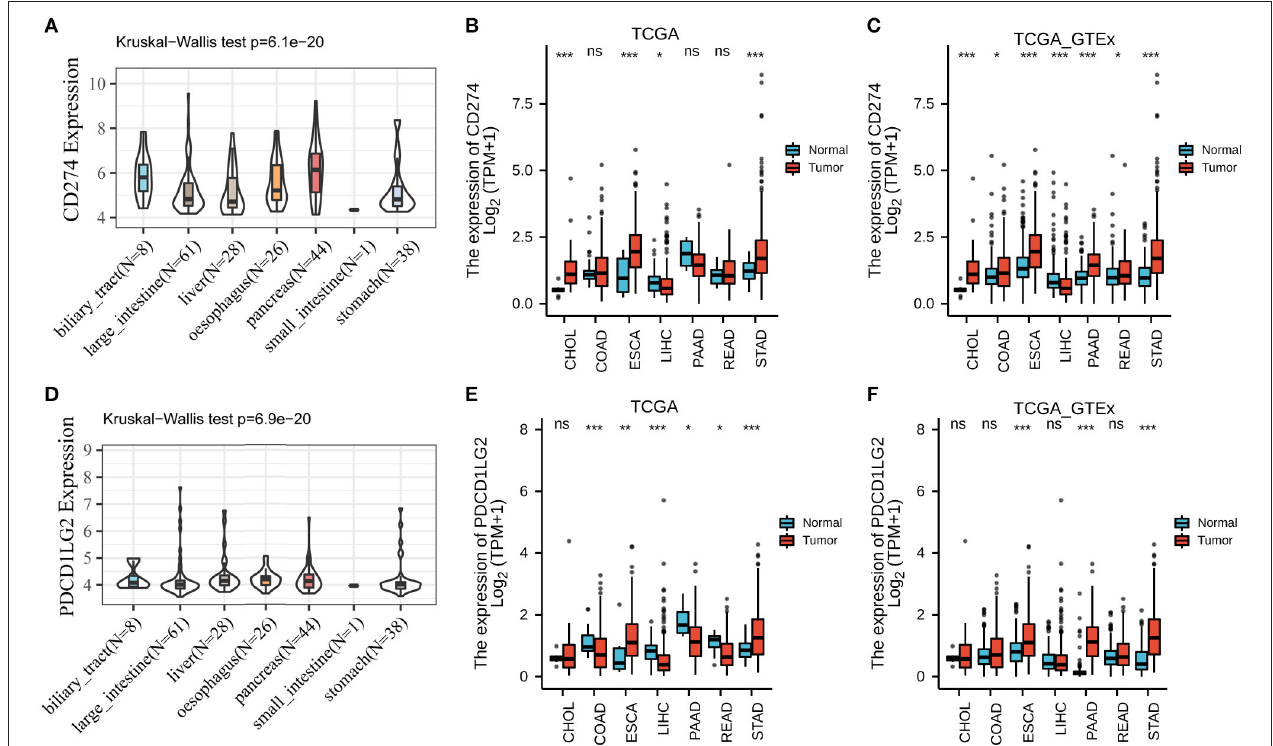
FIGURE 1 | CD274/PDCD1LG2 expression level in human pan-cancer. (A) The messenger RNA (mRNA) level of CD274 in Cancer Cell Line Encyclopedia (CCLE). (B) The mRNA level of CD274 in The Cancer Genome Atlas (TCGA). (C) CD274 mRNA level in TCGA and genotype-tissue expression (GTEx). (D) The mRNA level of PDCD1LG2 in CCLE. (E) The mRNA level of PDCD1LG2 in TCGA. (F) PDCD1LG2 mRNA level in TCGA and GTEx. * p < 0.05; ** p < 0.01; *** p < 0.001; ns, not significant.